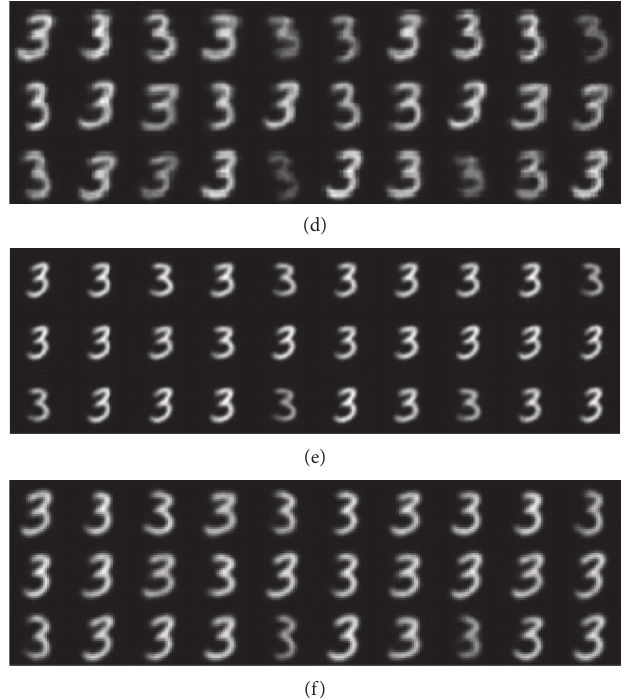
Figure 2: Comparison of algorithms in recovering handwritten digits. (a) Original; (b) RASL; (c) NQLSD; (d) PSSV; (e) MRASL; (f)